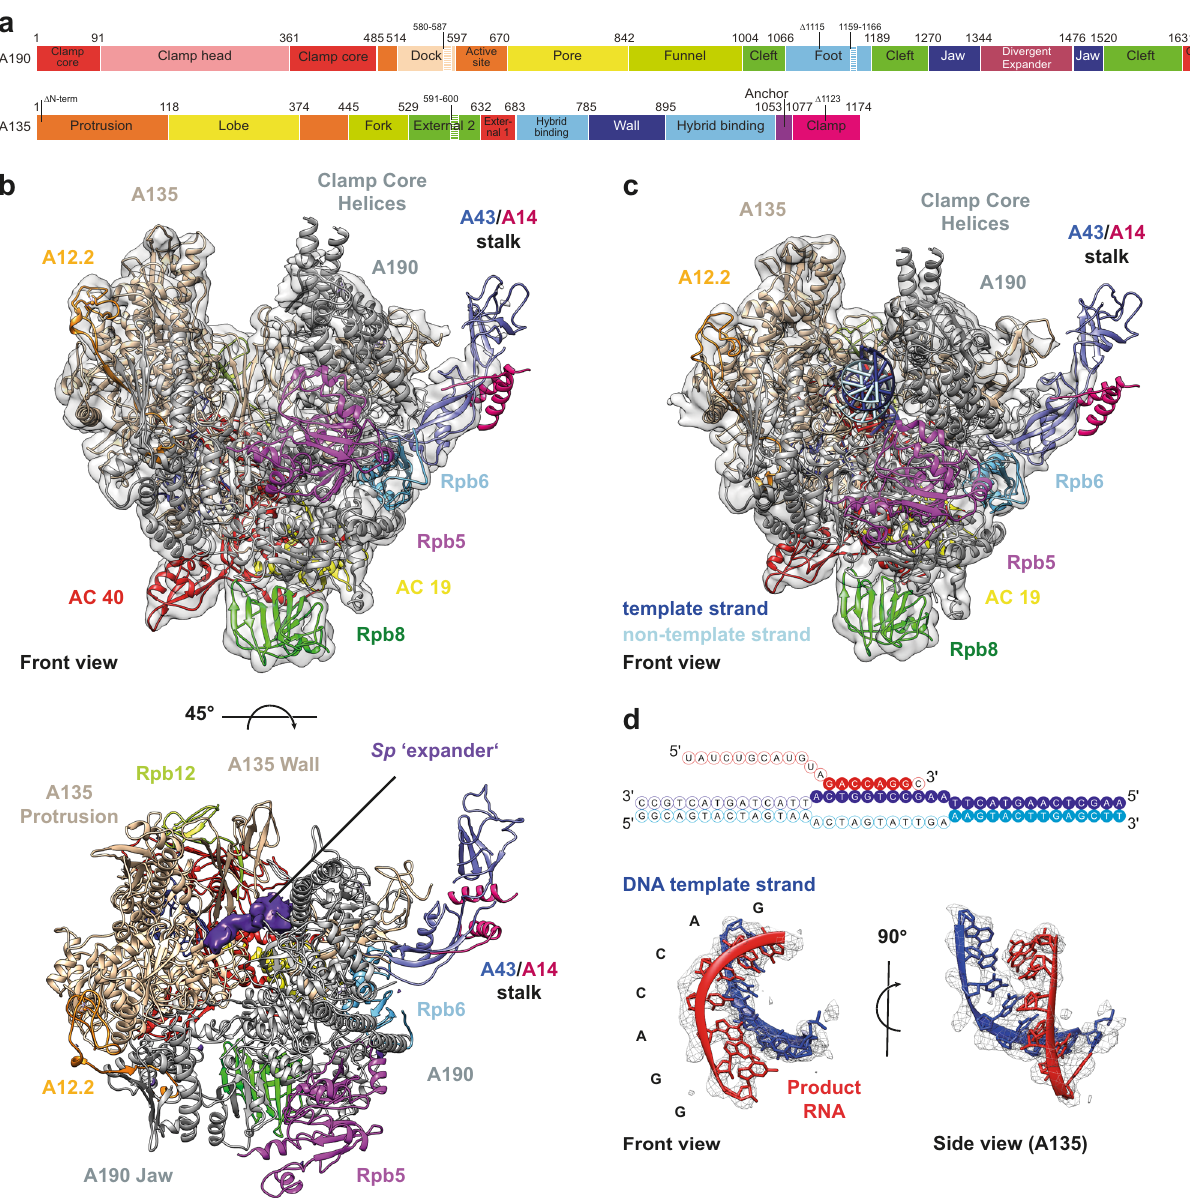
Fig. 1 Structure of monomeric and elongating S. pombe Pol I. a Sub-domain architecture of the Pol I subunits A190 and A135 in Sp . Insertion/Deletion of more than fi ve residues compared to Sc are highlighted. b Cryo-EM reconstruction of monomeric Sp Pol I. Transparent, unsharpened cryo-EM density overlaid with ribbon model shows 12 subunits but lacks the A49/A34.5 subcomplex. The cleft is expanded and density (purple, space- fi lling) indicates the location of the ‘ expander ’ element. c Cryo-EM reconstruction of an Sp Pol I Elongation complex. The cleft is contracted and the expander is displaced by the hybrid. d Schematic representation of the arti fi cial bubble construct used to establish an EC. Nucleotide bases included in the EC-density are highlighted. A model of the template-DNA/product-RNA hybrid overlaid with sharpened EC density is shown, the 3 ′ nucleotide of the RNA is present but shows poor density and was thus not